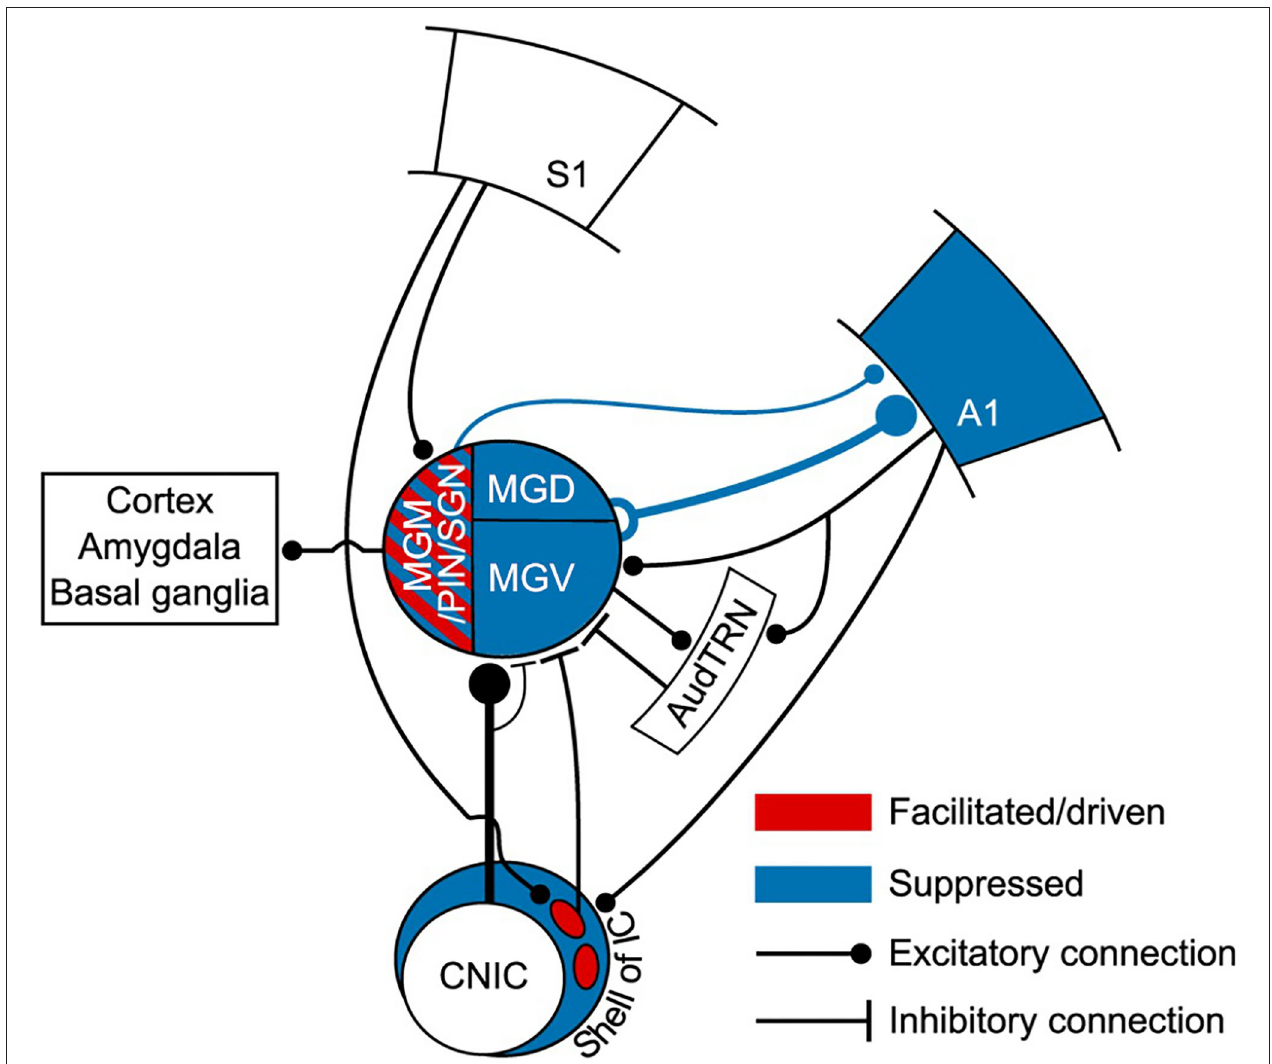
FIGURE 7 | Auditory thalamus and midbrain bridging primary somatosensory cortex (S1) to primary auditory cortex (A1). This scheme summarizes the findings of Lohse et al. (2021) study. This study elegantly undisclosed the multisensory circuits by which the primary somatosensory cortex controls activity in the thalamocortical system in mice. In blue, regions of the auditory system (midbrain, thalamus and A1) that were suppressed to auditory stimulation (tones) by concurrent whisker stimulation (whisker deflection). Suppression occurred via a descending connection from S1 to neurons in the lateral shell of the inferior colliculus that project to the MGB. This resulted in a suppression of thalamocortical neurons and suppression of auditory activity in A1. Altogether, this forms a corticocolliculo-thalamocortical multisensory circuit by which somatosensory information exerts a dominance over auditory processing in A1. In red, some neurons in the medial sector of the auditory thalamus, including the MGM, had their auditory responses enhanced or driven with whisker stimulation. A direct connection arising in L5 of S1 to the medial sector of the MGB could mediate this enhancement. Because the MGM projects to cortical areas, including A1, this could form a transthalamic circuit bridging S1 to AC. However, this hypothesis needs further confirmation. A1, primary auditory cortex; AudTRN, auditory sector of the thalamic reticular nucleus; CNIC, central nucleus of the inferior colliculus; MGM/PIN/SGN, medial subdivision of the MGB/posterior intralaminar nucleus/suprageniculate nucleus; MGD, dorsal subdivision of the MGB; MGV, ventral subdivision of the MGB; S1, primary somatosensory cortex. Adapted from Lohse et al.